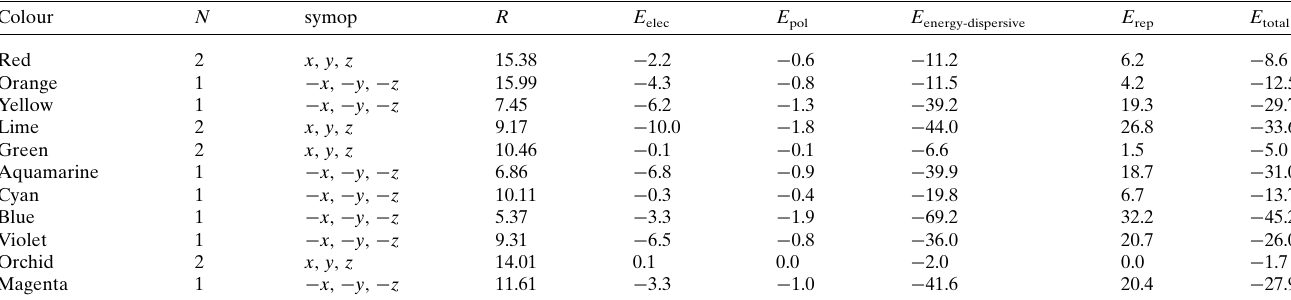
Table 3 Interaction energies (kJ mol (cid:5) 1 ). R is the distance between molecular centroids (mean atomic position) in A˚ and N is the number of molecules at that distance. Colour N symop